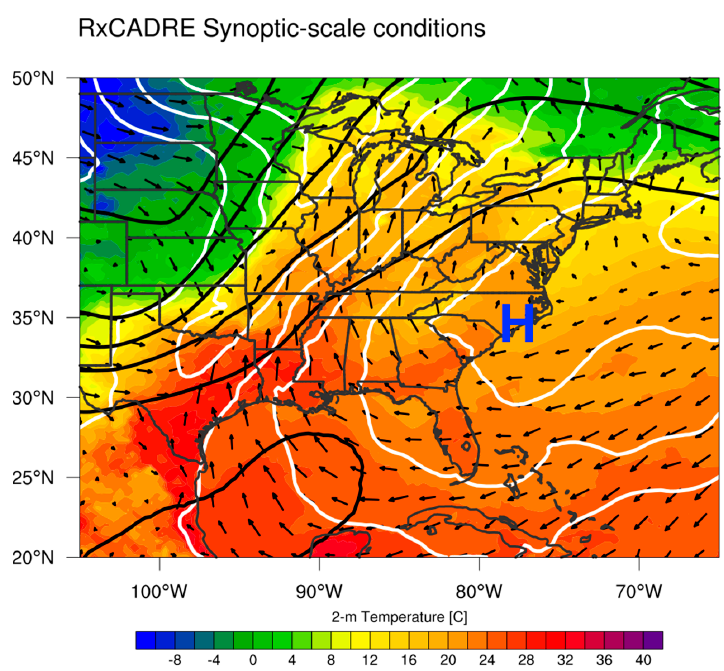
Figure 4. Synoptic-scale conditions during the L2F prescribed burn on 11 November 2012 at 1800 UTC. Wind vectors denote 10-m winds, white solid lines are 1000-hPa geopotential heights, and the black solid lines are 500-hPa geopotential heights.